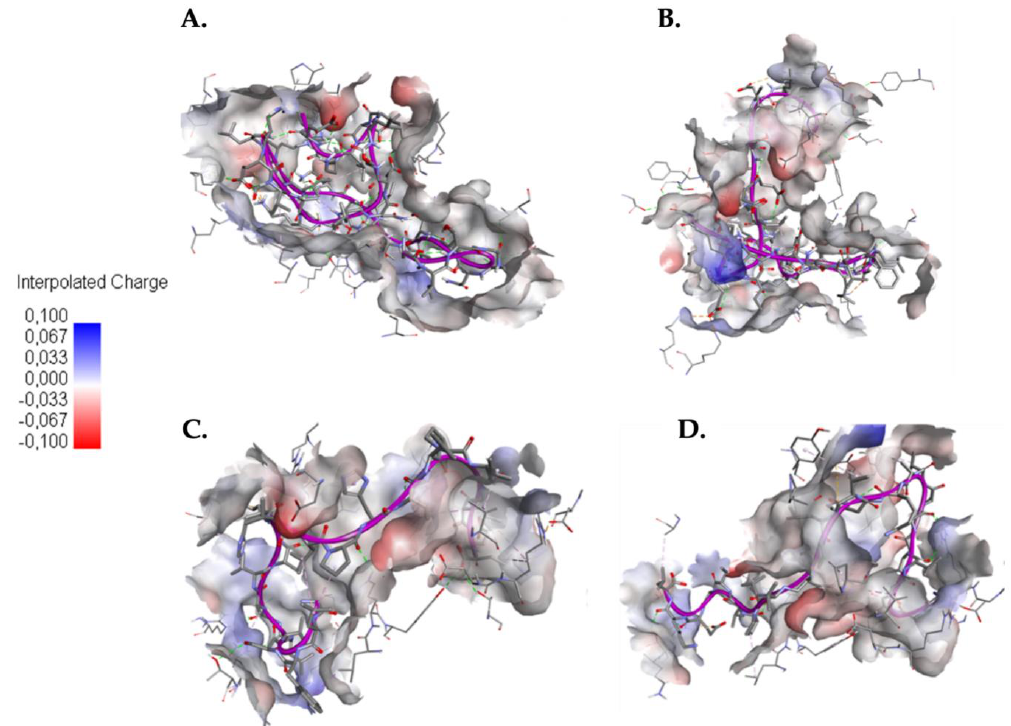
Figure 3. Docking between AMPs and Sgp. ( A ) Interaction between SARS-CoV-HR2P and Sgp; ( B ) Interaction between EK1 and Sgp; ( C ) Interaction between caerin 1.6 and Sgp; ( D ) Interaction between caerin 1.10 and Sgp. Red indicates negative charge and blue indicates positive charge of the Sgp binding site. Table 5. Comparison of binding energy and interactions between control peptides and caerins to the Sgp.